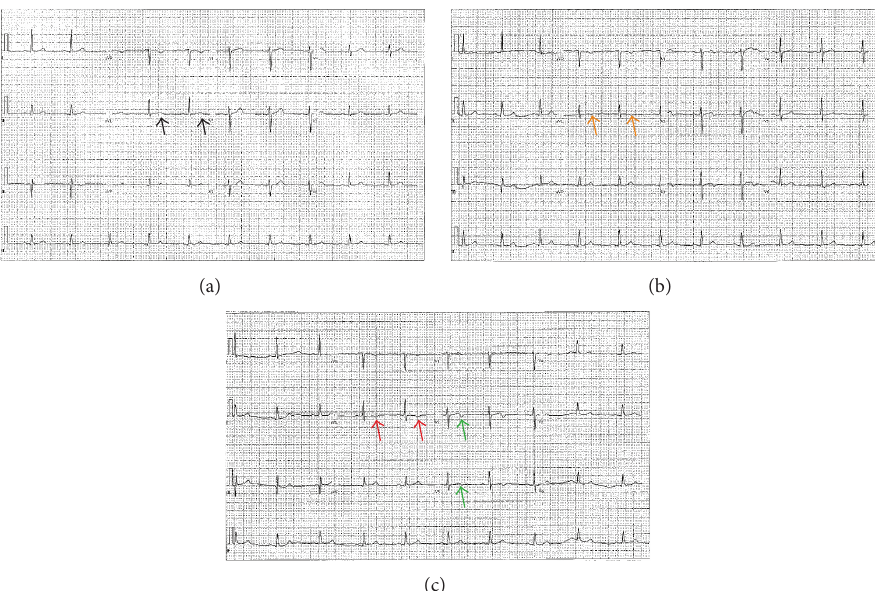
Figure 3: Dynamic T wave changes on ECG. (a) Upright T wave in lead aVL (black arrows, old ECG); (b) T wave flattening and early inversion in lead aVL (orange arrows, ECG at presentation); (c) TWI in lead aVL (red arrows, repeat ECG) and biphasic T waves in leads V2 and V3 (green arrows).